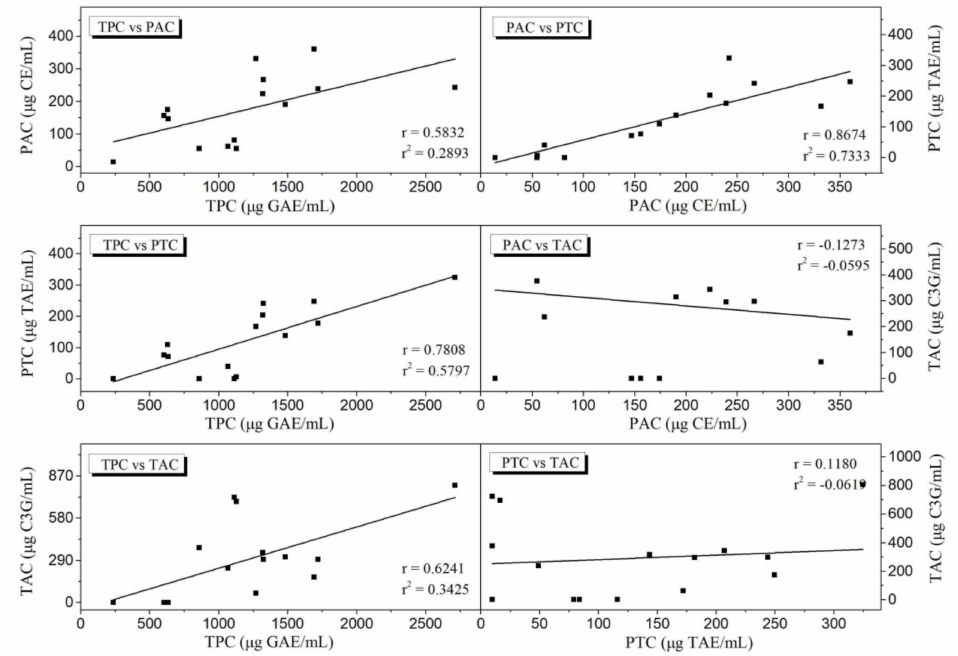
Figure 3. Plots of the correlations between the TPC and the PAC, the TPC and the PTC, the TPC and the TAC, the PAC and the PTC, the PAC and the TAC and the PTC and the